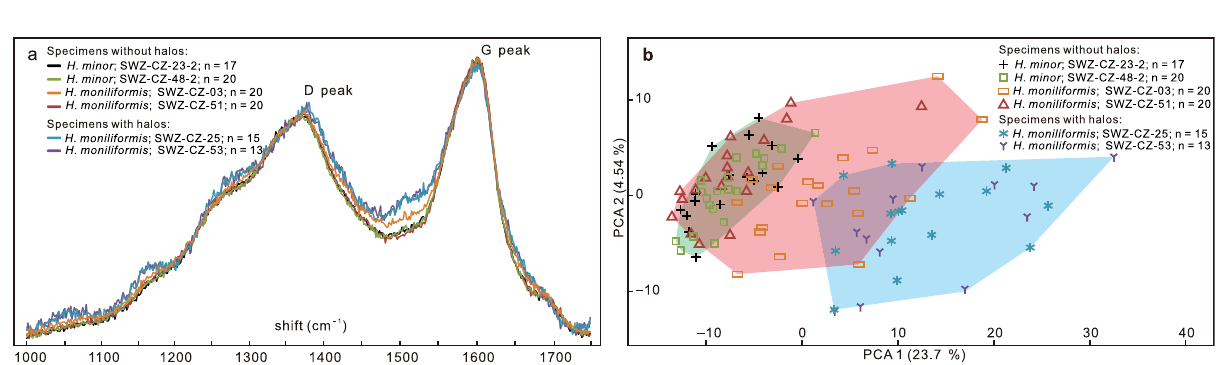
Fig. 7 Raman spectroscopy of beads of four Horodyskia moniliformis specimens and two Horodyskia minor specimens from the Tonian Shiwangzhuang Formation. a Average baseline-corrected and normalized Raman spectra of beads from six Horodyskia specimens. The beads of two H . moniliformis specimens (SWZ-CZ-25 and SWZ-CZ-53) are enveloped by halo, and the rest are not. Note that the six Raman spectra are not apparently different in D peak and G peak positions, nor in D/G peak intensity ratio. b Principal component analysis (PCA) of all baseline-corrected and normalized Raman spectra measured on six specimens, showing largely overlapping chemospace distributions among Horodyskia specimens without halos (red convex hull: H . moniliformis ; green convex hull: H . minor ), but marginally overlapping chemospace distributions between Horodyskia specimens with (blue convex hull) and without halos (red and green convex hulls). Letter “ n ” represents number of spectra collected from each specimen. See also Supplementary Data 2 for source data.